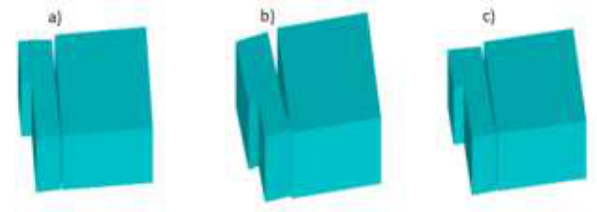
Figure 7. 3D models reconstructed from data collected